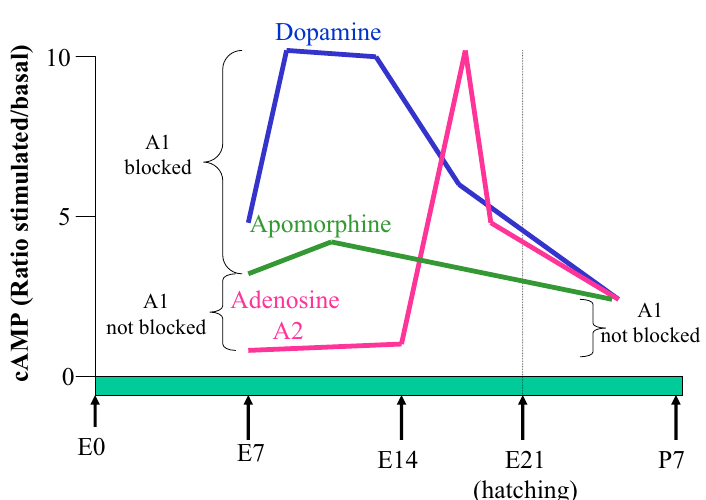
Fig. 1 – Summary of changes of cyclic AMP levels stimulated by activation of dopamine and adenosine receptors during development of the chick retina. Dopamine receptors were stimulated by dopamine or the partial agonist apomor- phine. Notethedifferenceinthestimulated/basalratiowhenretinaswereexposed to dopamine or apomorphine in the embryonic period while the ratio is similar at the post-hatching period. The activation of adenosine A1 receptors blocks the stimulation by dopamine, but not apomorphine, in the embryonic retina. At the post-hatching period, the effects of both dopamine or apomorphine are not regulated by A1